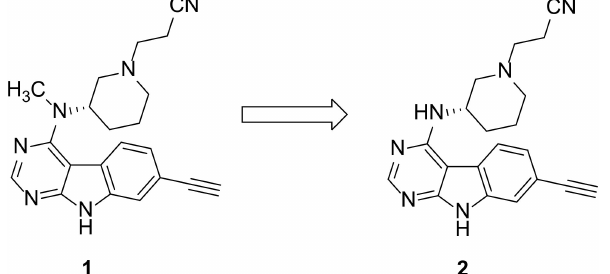
Figure 1. Structure of GSK-3 β inhibitor 1 and the design of the title compound 2